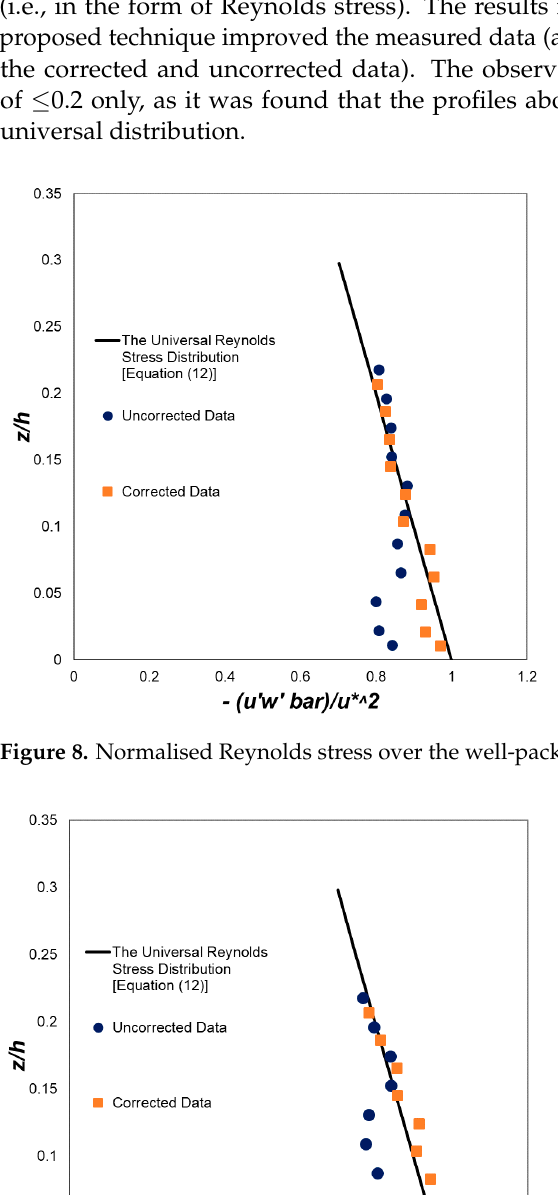
Figure 9. Normalised Reynolds stress over the sediment transport-induced water-worked bed.